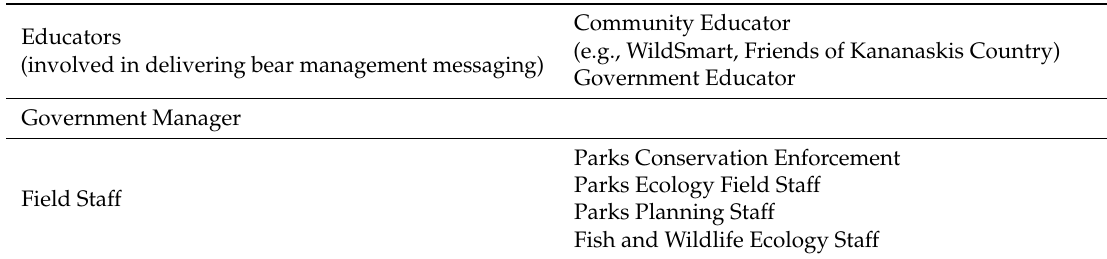
Table 1. Categories of decision-makers identified in